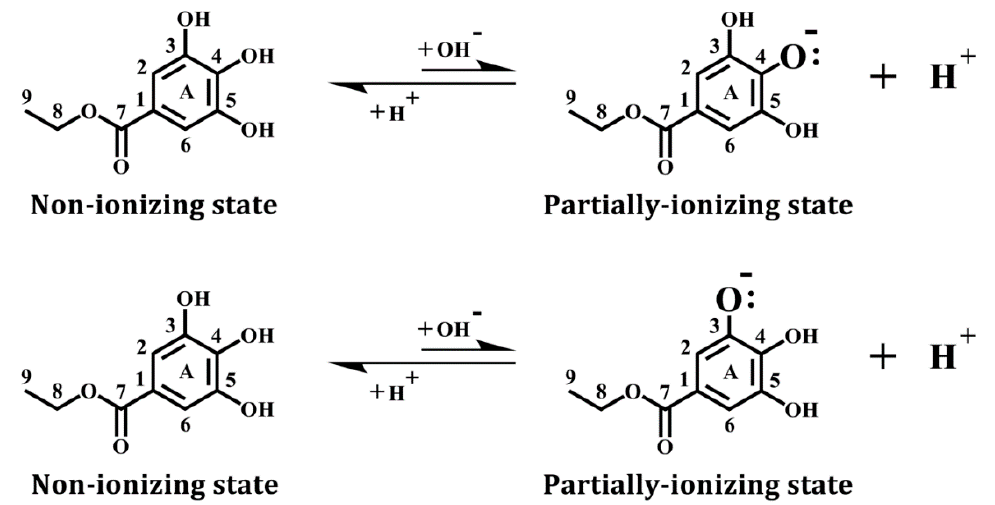
Figure 1. Chemical structure of ethyl gallate, a natural phenolic compound. For instance, after ionization (deprotonation) of the C-4-OH hydroxyl group, its oxygen atom in this hydroxyl group carries a negative charge with an additional electron retained. Similar ionization can also occur with the C-3-OH group, as well as the C-5-OH group.